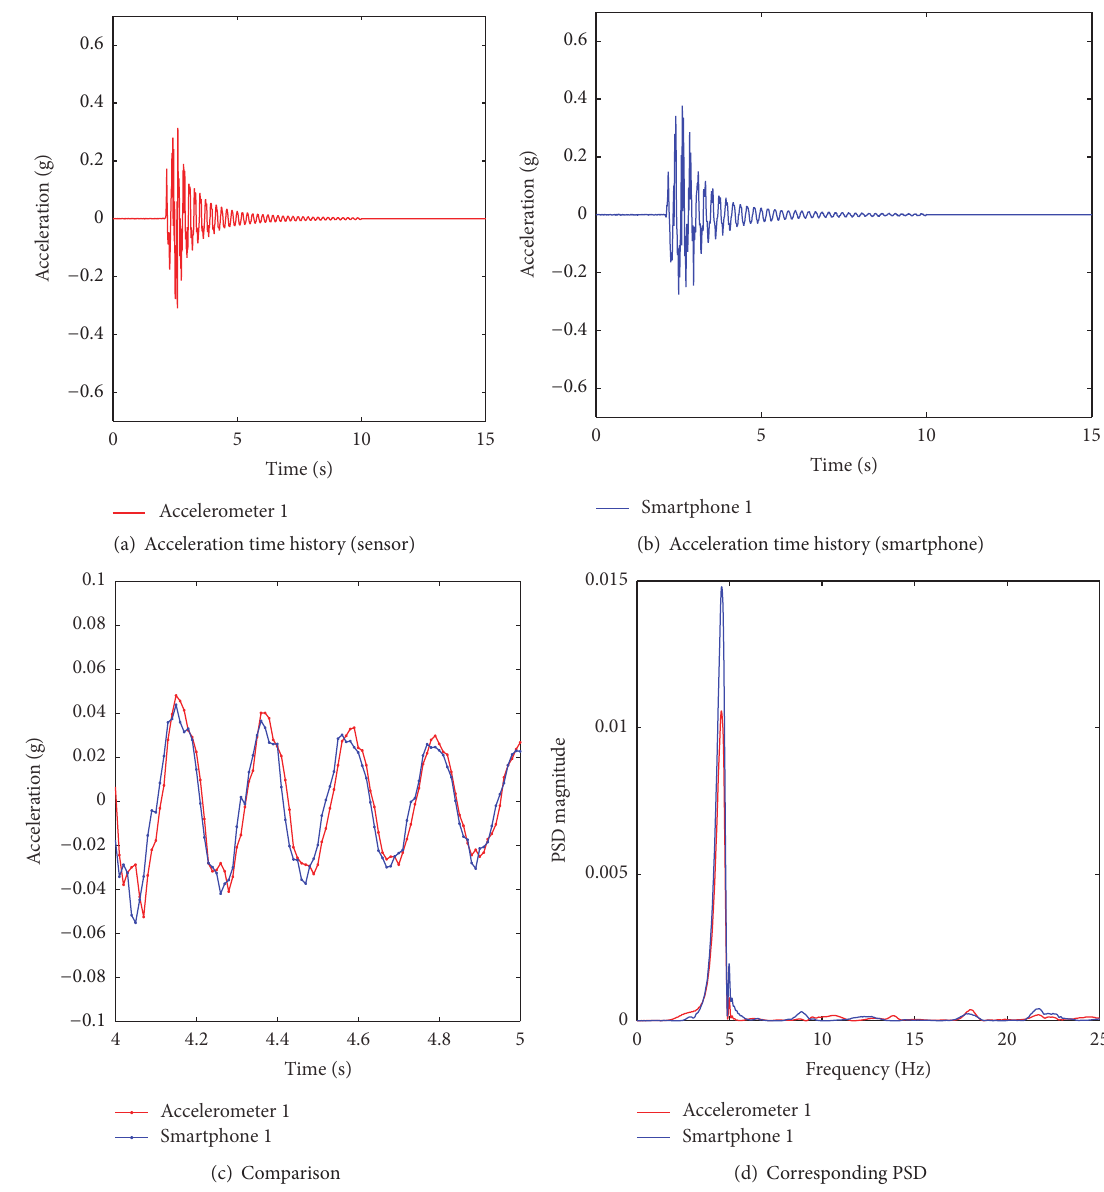
Figure 12: Acceleration measurements (left quarter span).